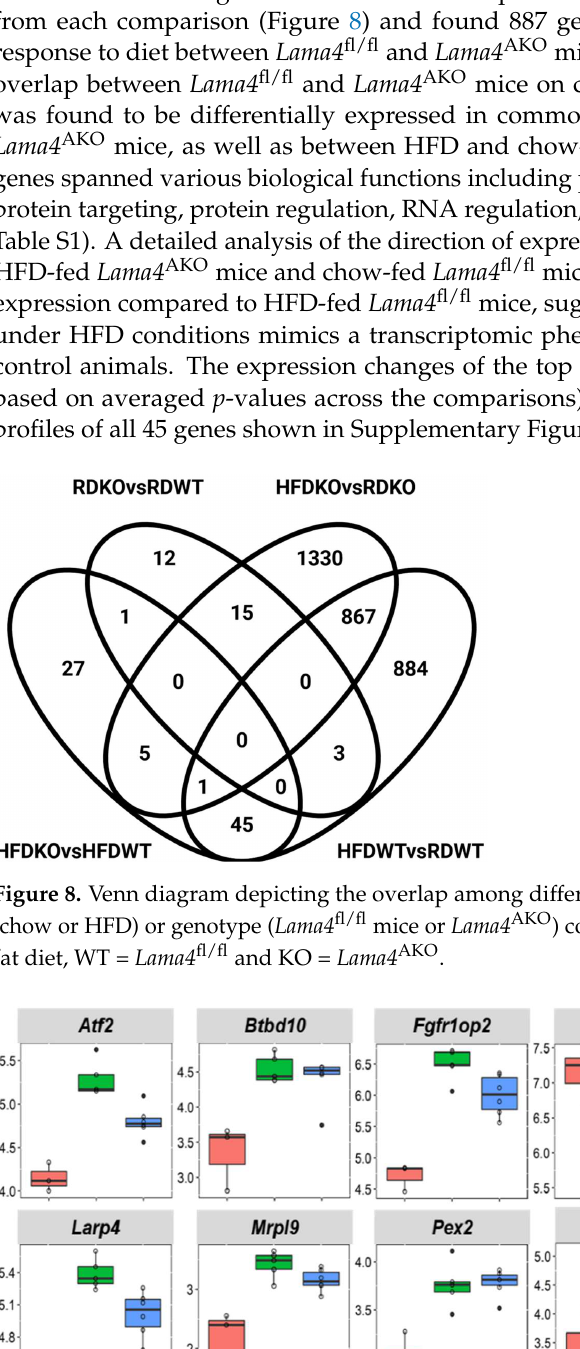
Figure 9. Boxplots of top ten genes differentially expressed in common between HFD-fed Lama4 fl/fl and Lama4 AKO mice, as well as between HFD and chow-fed Lama4 fl/fl mice. log2CPM = log 2 counts per million, RD = chow diet, HFD = high-fat diet, WT = Lama4 fl/fl and KO = Lama4 AKO . Atf2 = activating transcription factor 2, Btbd10 = BTB domain containing 10, Fgfr1op2 = FGFR1 oncogene partner 2, Grcc10 = gene-rich cluster, C10 gene, Gtf2h1 = general transcription factor IIH subunit 1, Larp4 = La ribonucleoprotein 4, Mrpl9 = mitochondrial ribosomal protein L9, Pex2 = peroxisomal biogenesis factor 2, Srpr = signal recognition particle receptor subunit alpha.